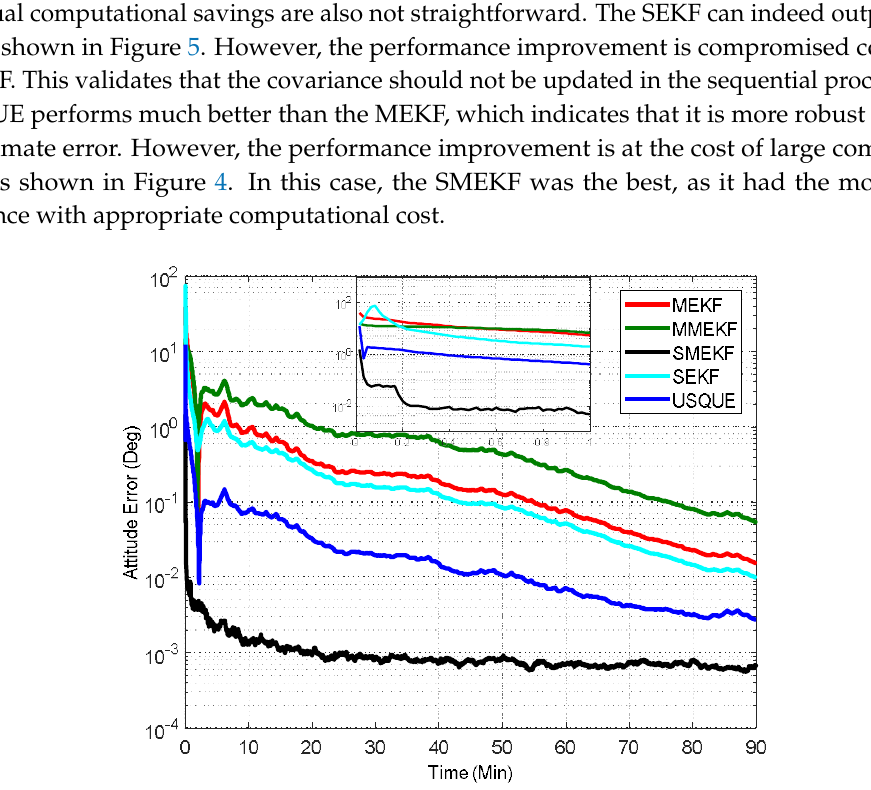
Figure 4. Averaged estimator runtime.